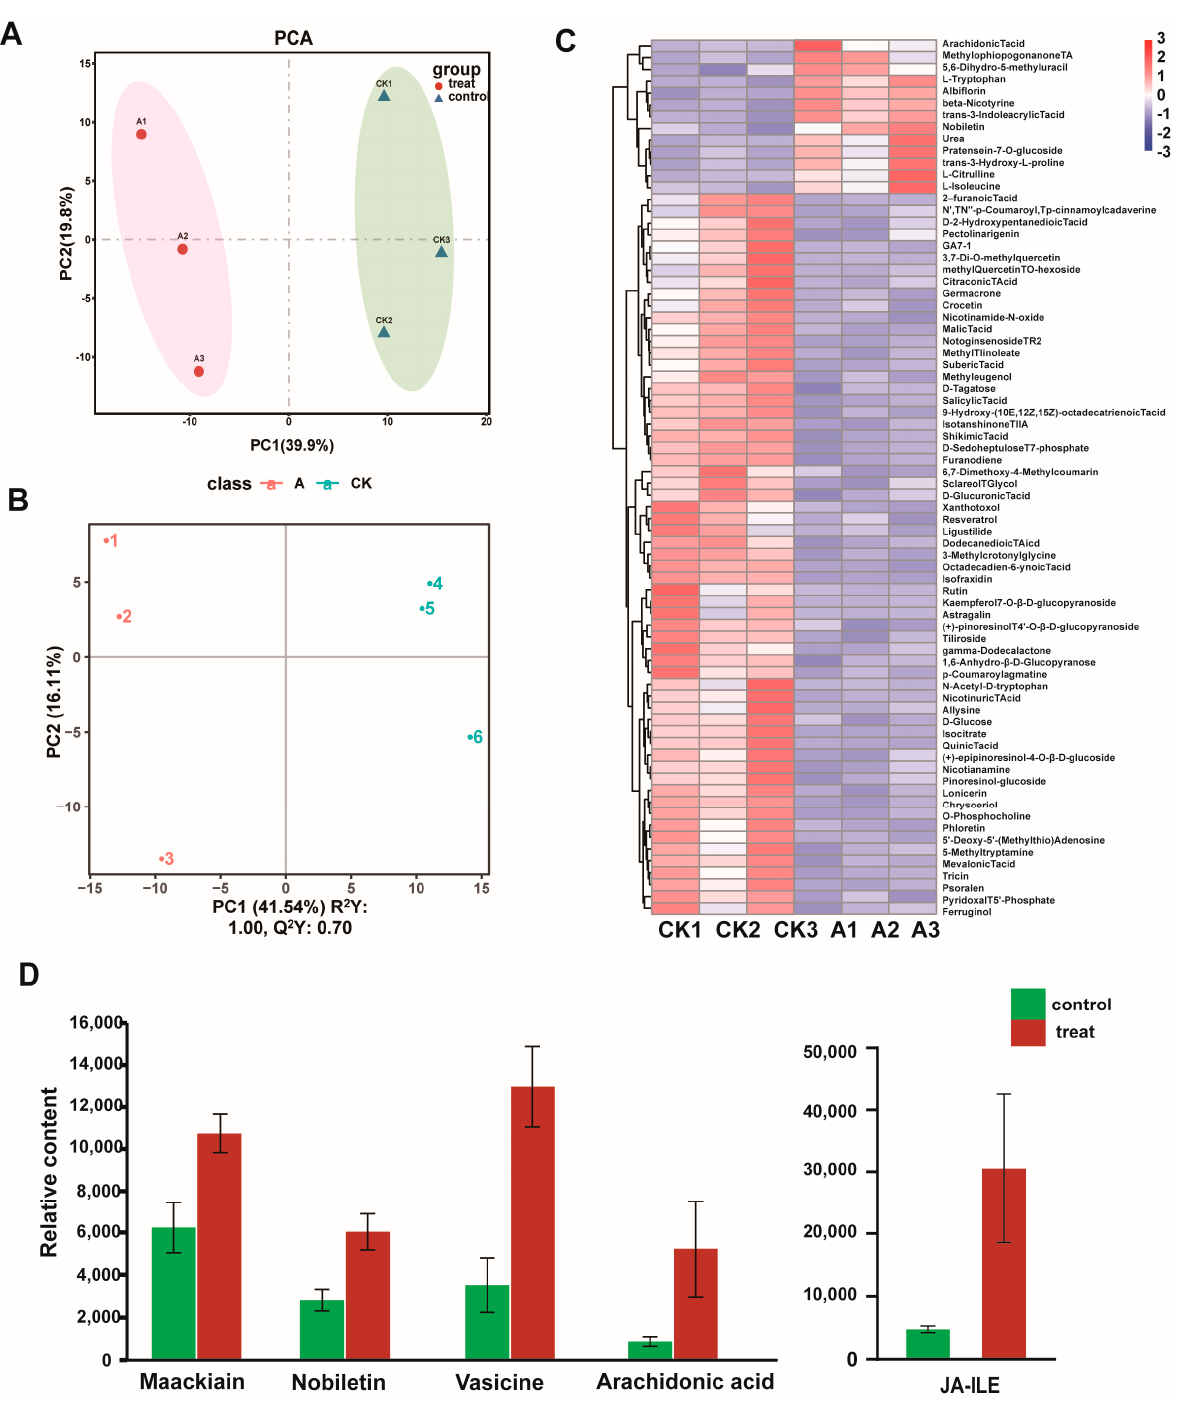
Figure 1. Data analysis of the metabolome in Mikania micrantha . ( A ) Principal component analysis (PCA) of metabolome data from healthy and infected leaves of M. micrantha . Axes showed the per- centage of variance of the first two components (PC1, PC2). The circle represents the treatment group, and the triangle represents the control. ( B ) Partial least-squares discriminant analysis (PL − SDA) plots of untreated (control) and P. spegazzinii treated leaves. ( C ) Heatmap hierarchical clustering of differentially expressed metabolites. The content of each metabolite was normalized to complete hierarchical clustering. Each example was visualized in a single column, and each metabolite is represented by a single row. Red indicates high abundance, whereas low relative metabolites are shown in blue. ( D ) Secondary metabolite content associated with immune response in M. micrantha under P. spegazzinii stress. The error bars represent the means ±